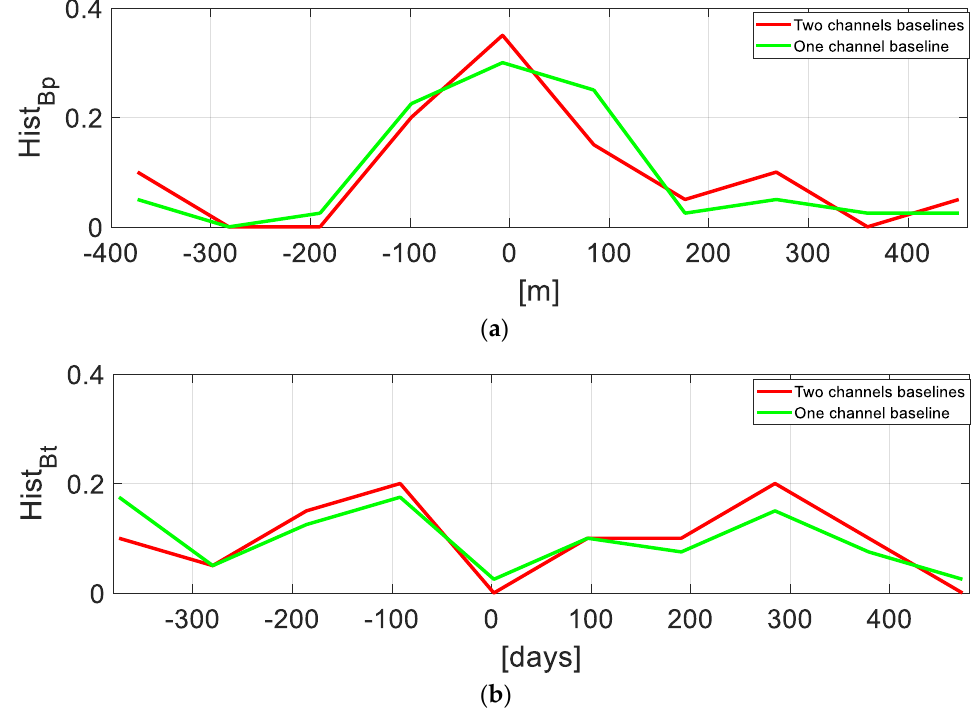
Figure 3. Normalized histogram of the perpendicular baseline distribution ( a ) and of the temporal baseline distribution ( b ); in green, the single polarization case and, in red, the dual polarization case.